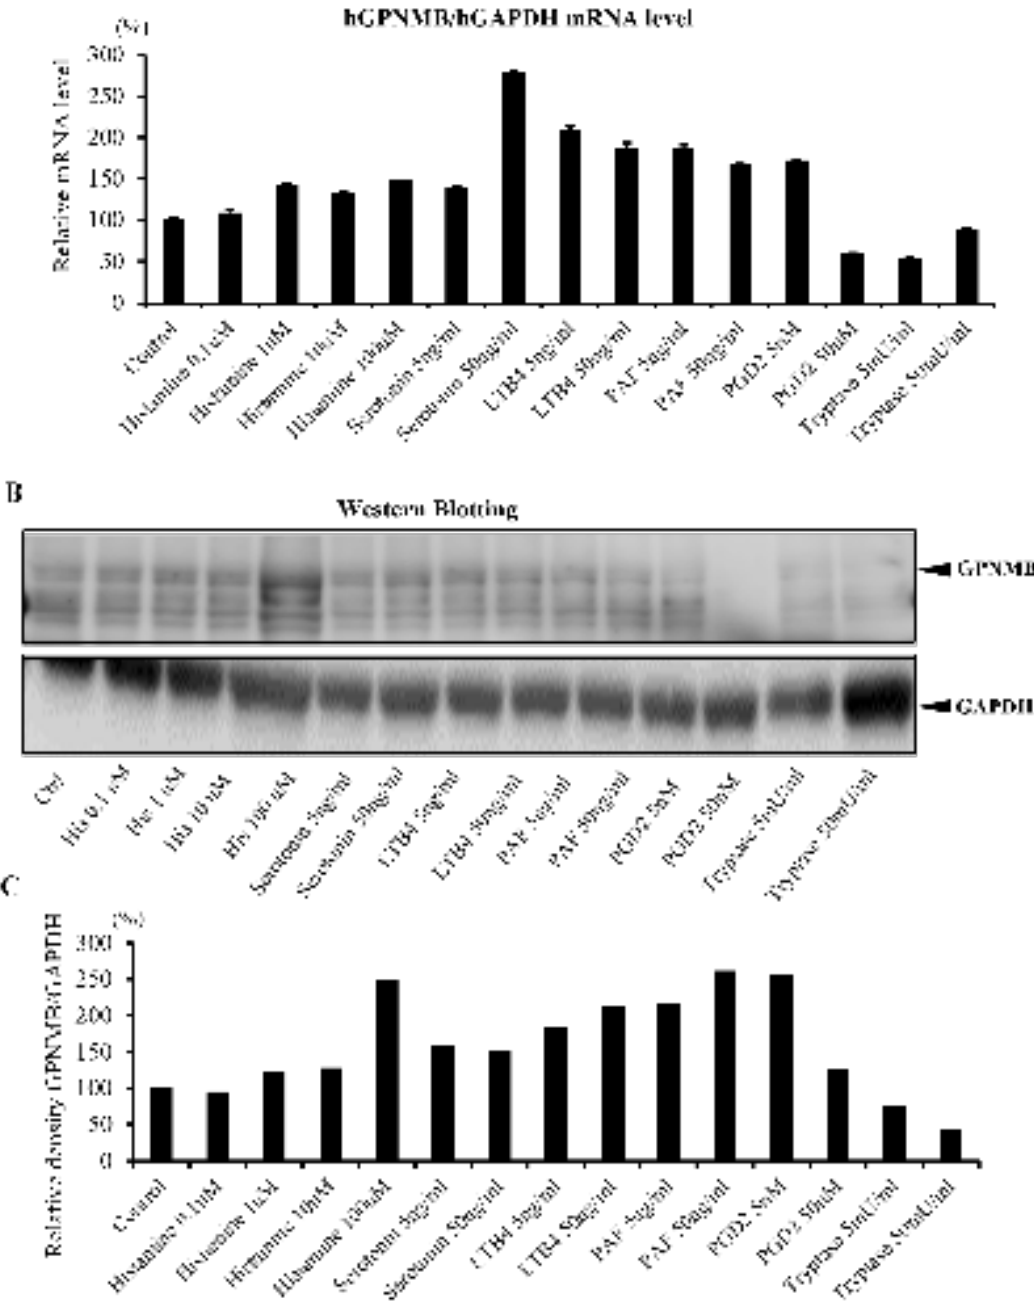
Figure 7. Effect of mast cell-derived mediators on GPNMB expression. Cultured human epidermal keratinocytes PSVK1 were stimulation with the indicated reagents, 24 h after stimulation, cells were collected for RNA extraction, 48 h after stimulation, cells were collected for protein extraction. The mRNA expression (A) and the protein expression (B, C) level of GPNMB were analyzed by real-time PCR (A) and western blotting (B, C). LTB4: leukotriene B4; PAF: platelet-activating factor; PGD2; prostaglandin